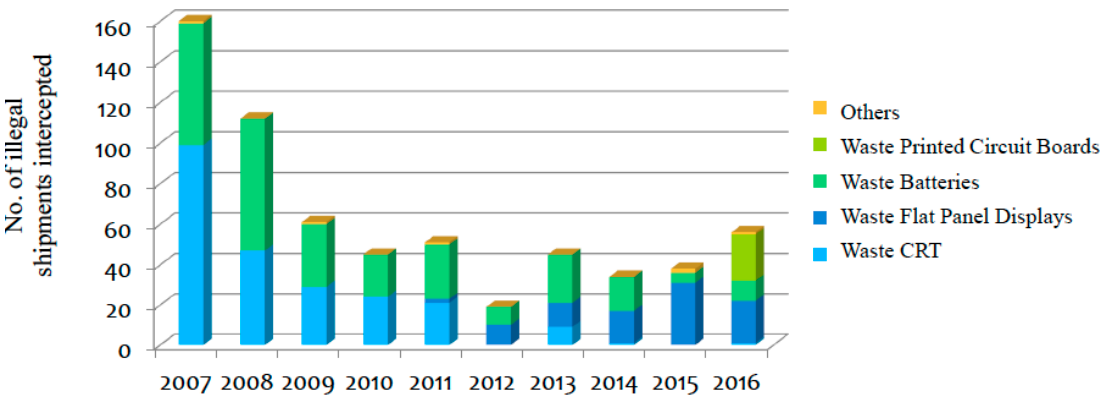
Figure 2. Number of illegal shipment intercepted in 2007–2016 [29].